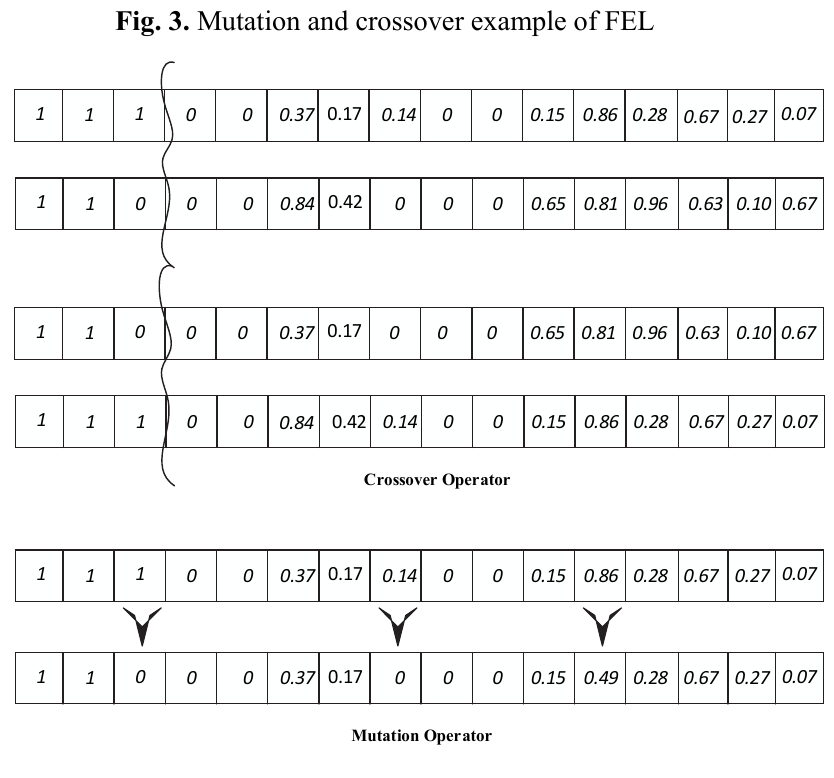
Fig. 4. Crossover and mutation example of